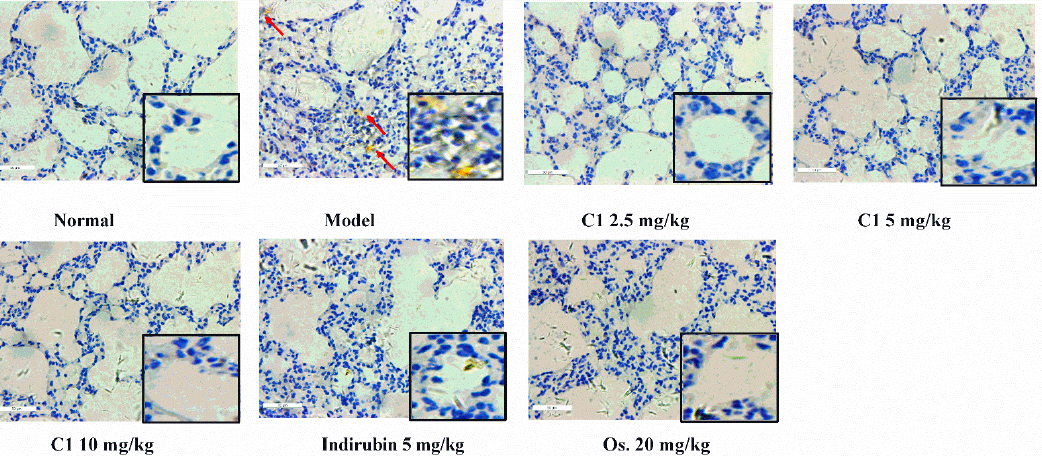
Figure 6. The effect of C1 on the recruitment of Iba-1 macrophages and monocytes in the ALI model; the experiment design is the same as Figure 3. The lung tissue of H1N1-infected mice was harvested, fixed in formalin, and embedded in paraffin and processed for slices preparation. The slides were incubated with relative antibodies against ionized calcium-binding adaptor molecule-1 (Iba-1), stained with a chromogenic substrate and counterstained with hematoxylin. The immuno-histochemical (×400) expression of Iba-1 in the lung of H1N1-infected mice was observed under a microscope. The scale bar represents 50 μ m. Magnification: 400×; scale bars, 50 μ m.